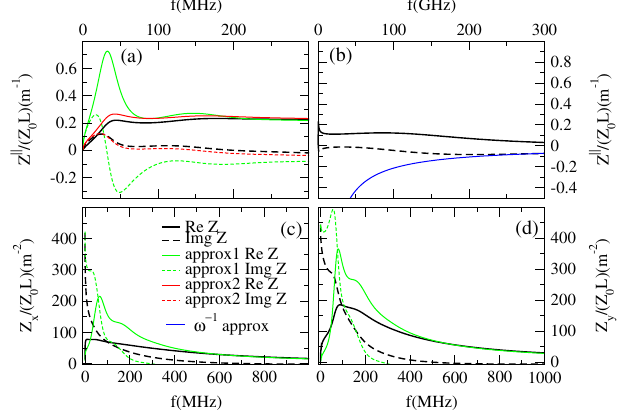
FIG. 4. Coupling impedances of a parallel-plane laminated chamber. We take b ¼ 2 : 1 cm , d ¼ 15 : 24 cm , h ¼ 4 : 75 , (cid:7) 100 , 9 : 52 (cid:3) 10 (cid:1) 4 cm , (cid:10) ¼ 6 : 35 (cid:3) 10 (cid:1) 2 cm , (cid:6) 1 r ¼ 2 r ¼ and (cid:8) 2 ¼ 0 : 5 (cid:3) 10 7 ð (cid:3)m Þ (cid:1) 1 (iron), parameters specific to the Fermilab Booster F-magnets. The real (imaginary) part is plotted with full (dashed) lines. The black lines show the full impedance calculation done by employing Eqs. (19), (21), and (23). Different approximations are also shown. The green lines are calculated by neglecting the (cid:5) dependence of the surface im- ð (cid:5) Þ(cid:4) R ð (cid:5) ¼ 0 Þ pedance, i.e., by making the approximation R z z and employing Eqs. (35), (38), and (39). (a) Low frequency and (b) high frequency longitudinal impedance. The red lines are calculated by considering the full (cid:5) dependence of the surface impedance and by neglecting the terms proportional to the surface impedance in the denominator of Eq. (19), i.e., by employing Eq. (32). (c) Horizontal transverse impedance. (d) Vertical transverse impedance. The impedance is about 2 orders of magnitude larger than 1 corresponding to a resistive- wall pipe made from the same material as the laminations. Note that neglecting the (cid:5) dependence in the surface impedance yields values that are too large for the coupling